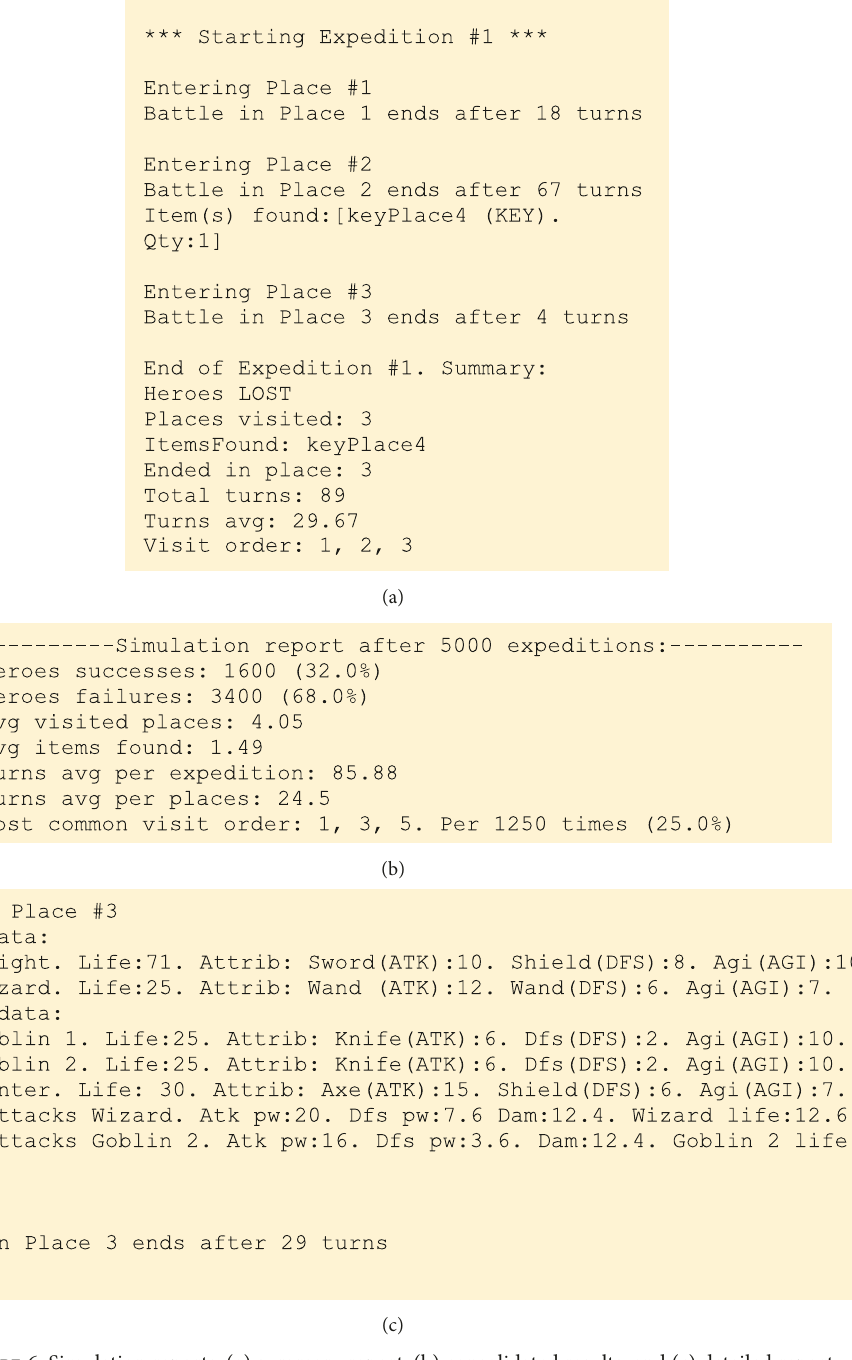
(f) Bar chart for the order in which the different places were